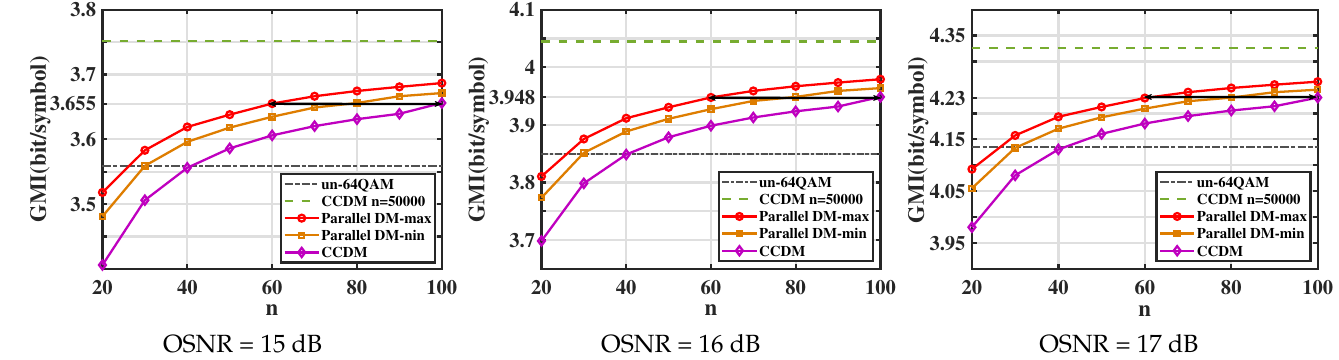
Figure 6. GMI in bit/symbol over block length n when OSNR = 15, 16, and 17 dB. When the GMI is the same, the parallel distribution matcher required block length n is only 60, while the required block length of CCDM is 100; so, the block length can be saved by 40%.